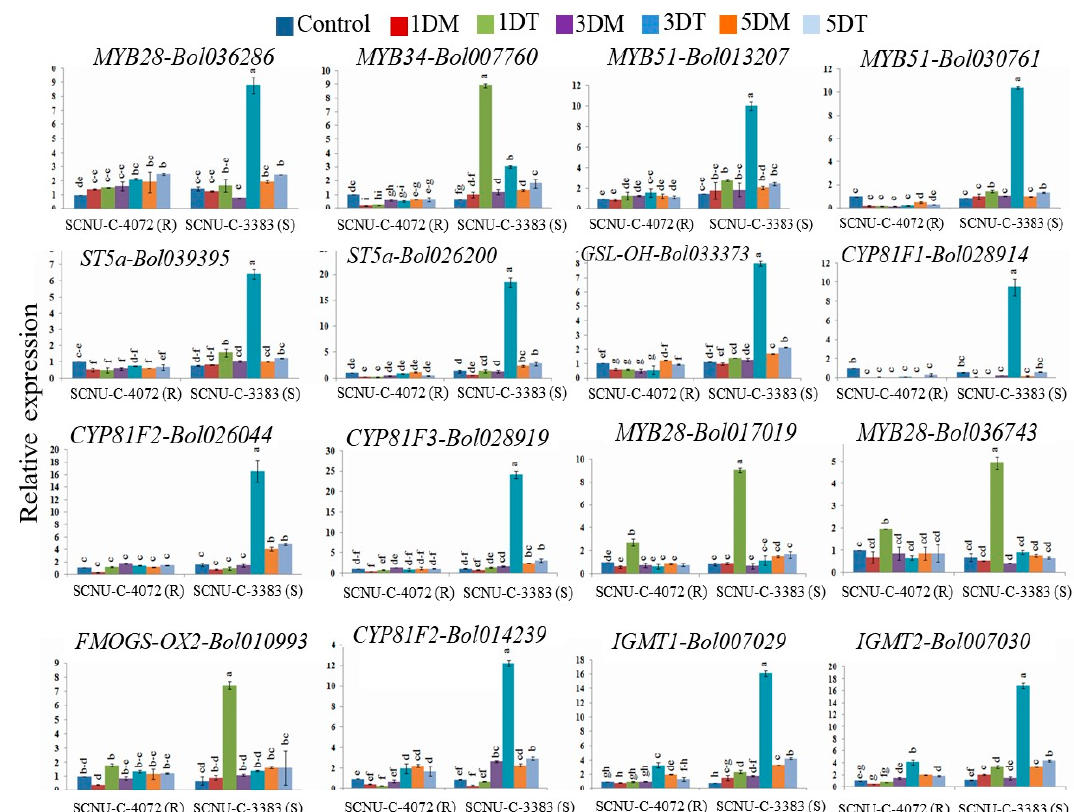
Figure 5. Relative expression of transcription factor-related and GSL biosynthesis genes in the black rot susceptible (SCNU-C-3383) line at di ff erent days after inoculation (1, 3, and 5 DAI) using Xcc pathogen under di ff erent treatment conditions (C, control; 1DM, 1 day mock; 1DT, 1 day treated; 3DM, 3 day mock; 3DT, 3 day treated; 5DM, 5 day mock; 5DT, 5 day treated) compare to mock-treated samples. Vertical bars indicate the standard deviation. Di ff erent letters indicate statistically significant di ff erences ( p < 0.01) between genotypes (R: SCNU-C-4072 and S: SCNU-C-3383) lines and treatment interactions following Tukey test. R, resistant; S,